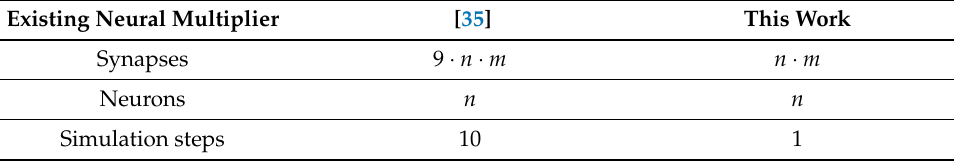
Table 4. Comparison between the proposed neural multiplier and the existing neural multiplier [35] in terms of simulation steps, synapses and neurons. Where n denotes the number of digits of v and u . Adapted from